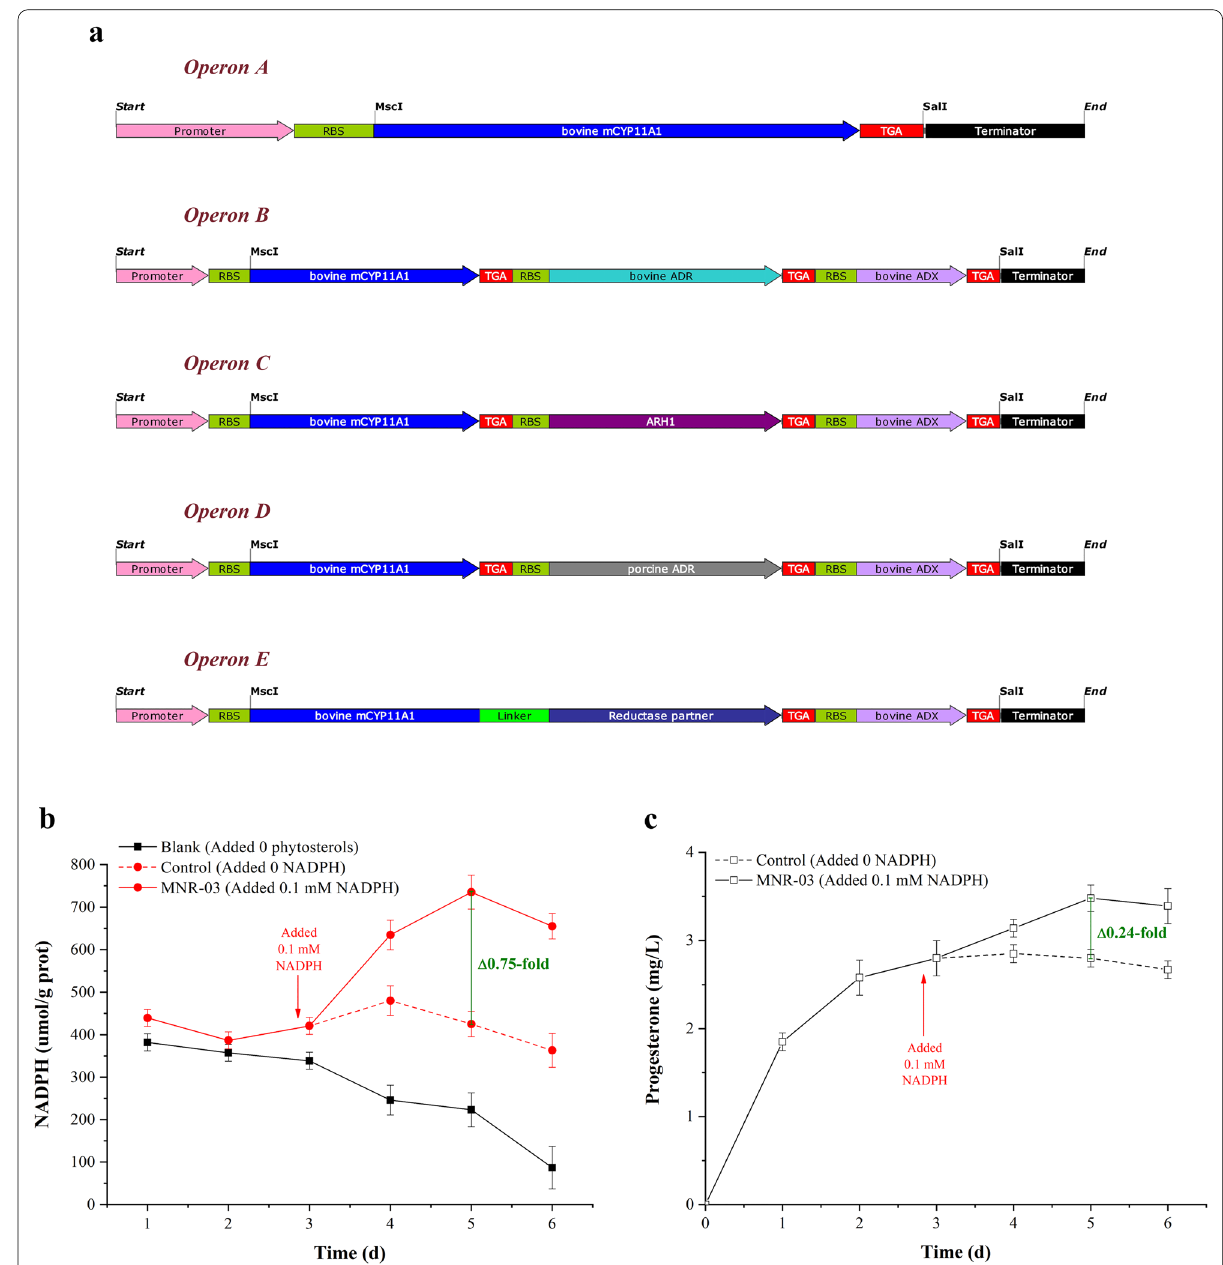
Fig. 2 Overcoming the interdependence of P450 catalysis between CYP11A1 and reductase partners in M. neoaurum . a Overview map of bacterial operon mainly contains genes cyp11a1 and its partners. RBS: GGA GGA A, Linker (L): (GGGGS) 2 . b Intracellular NADPH concentration of MNR‑03. c Corresponding to progesterone titer of the b . The value of the control group was treated as unit one on fermentation of the fifth day. All NADPH assays were performed before bacterial sludge were washed 3 times using PBS buffer and ddH 2 O,